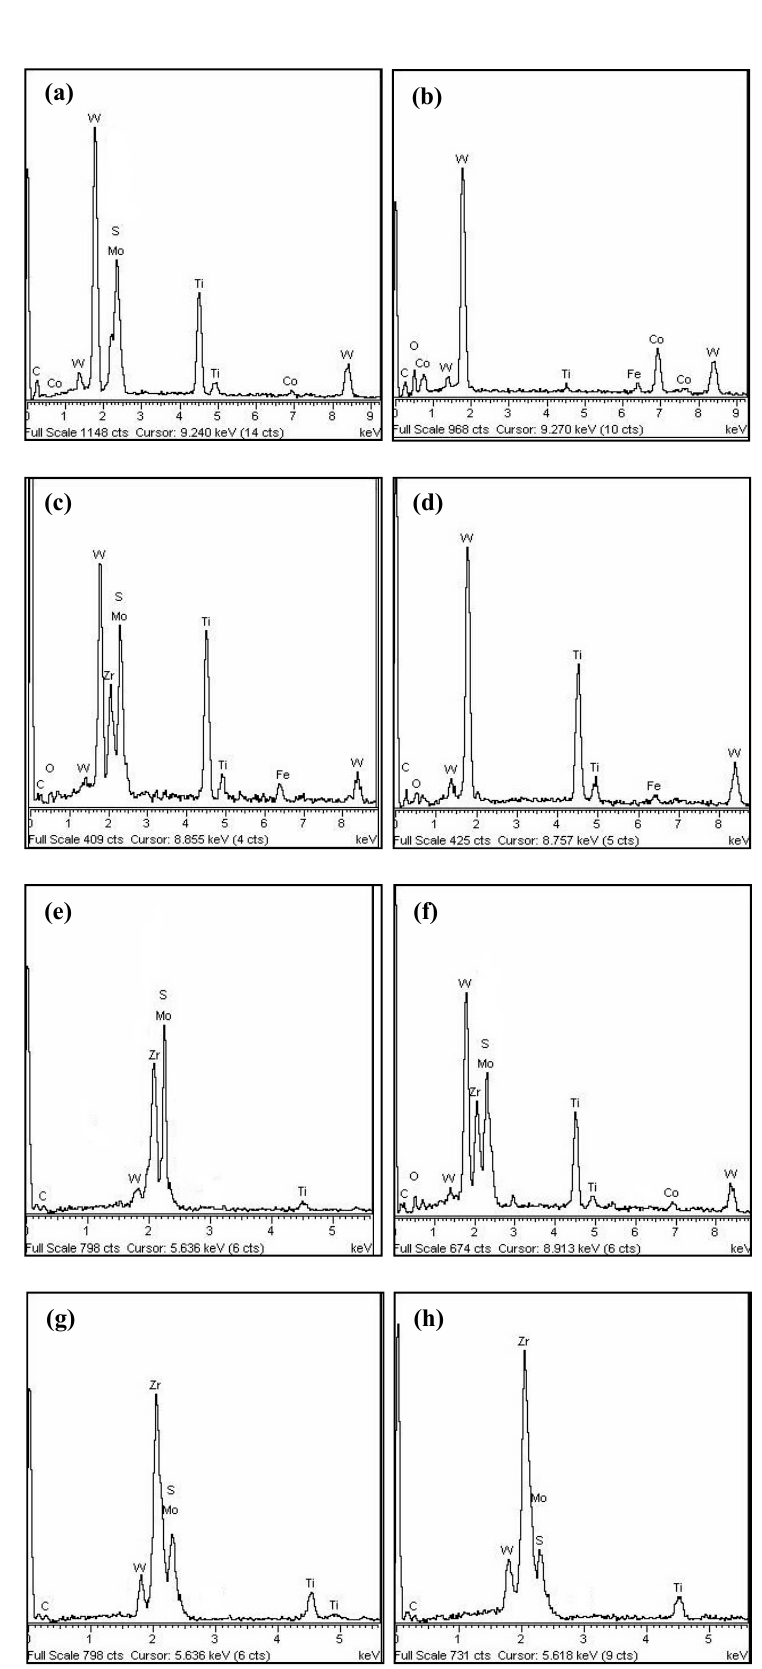
Figure 15. The corresponding EDX composition analysis of points A–H in Figure 14: ( a ) point A; ( b ) point B; ( c ) point C; ( d ) point D; ( e ) point E; ( f ) point F; ( g ) point G; ( h ) point H .